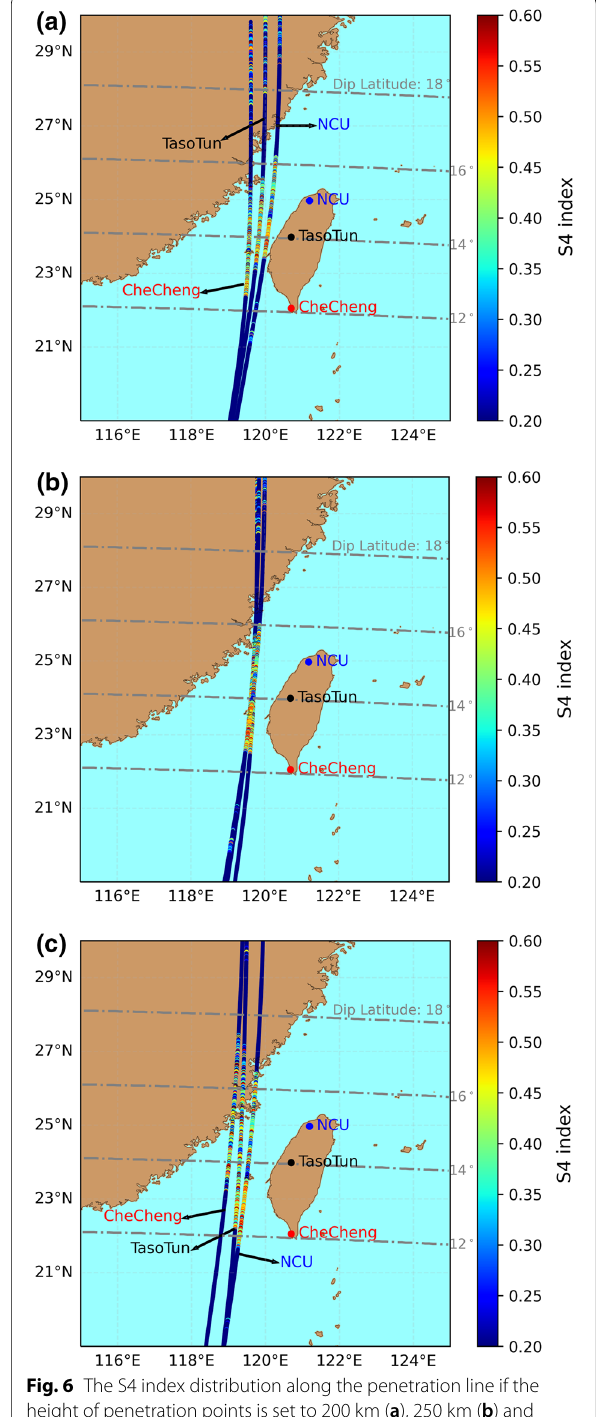
Fig. 6 The S4 index distribution along the penetration line if the height of penetration points is set to 200 km ( a ), 250 km ( b ) and 350 km ( c